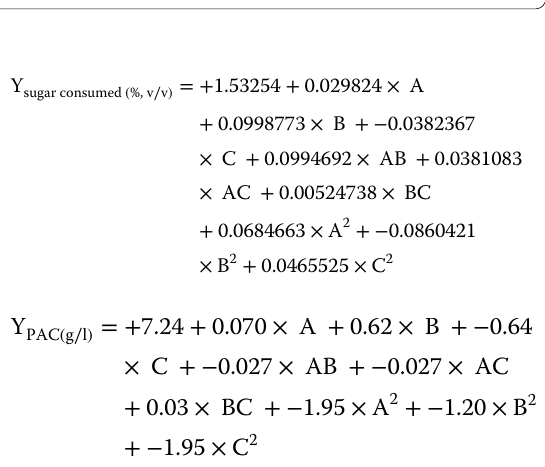
Fig. 2 Scaled standard error of